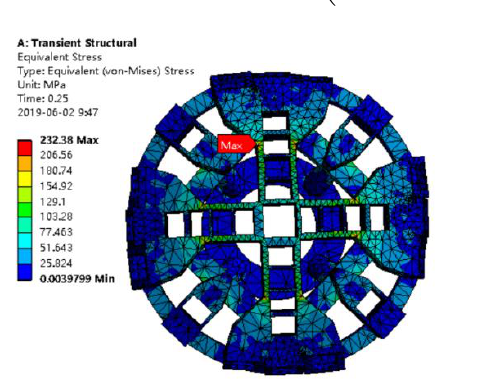
Figure 10. Transient dynamics nephogram.